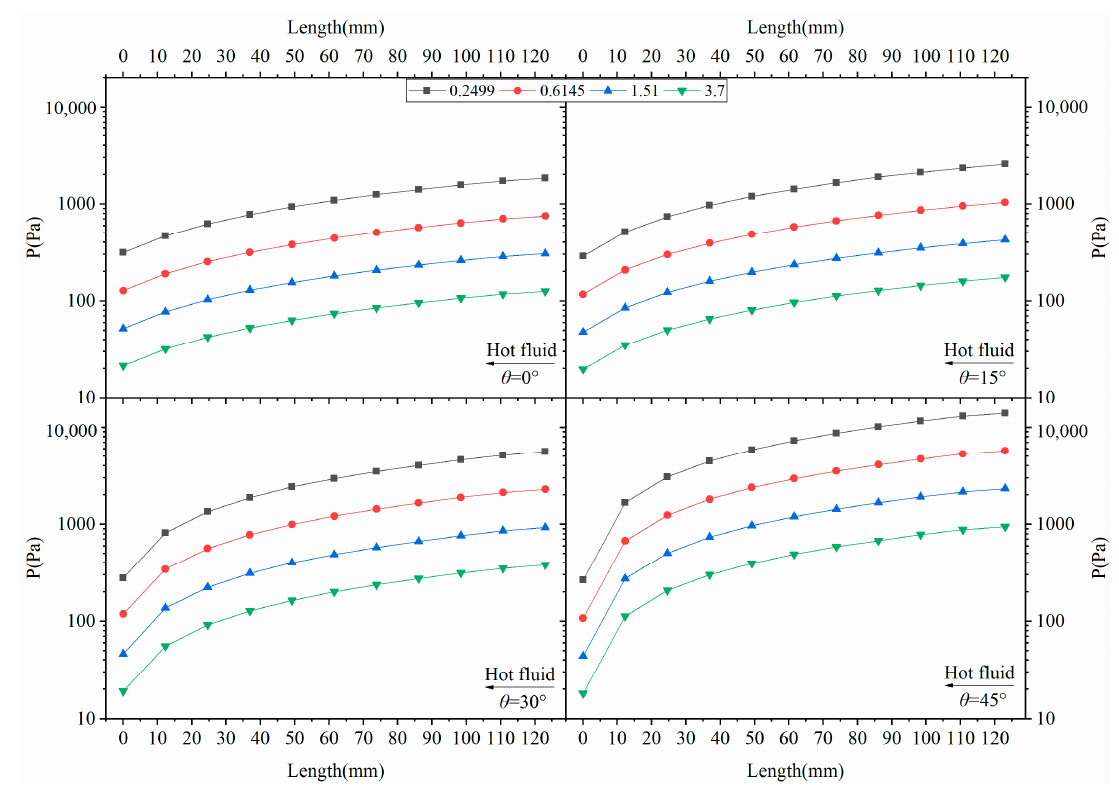
Figure 7. Resistance characteristics of the hot fluid.